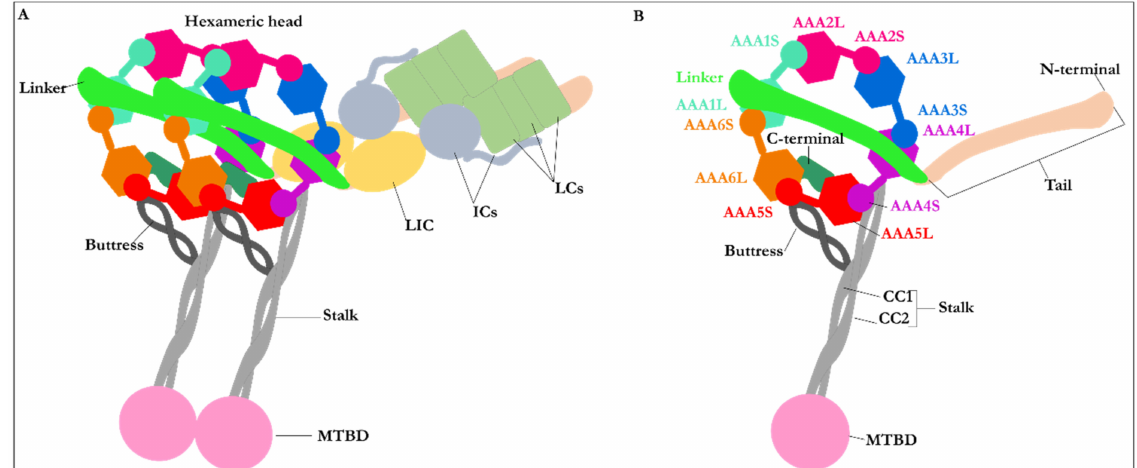
Figure 1. The multidomain structure of cytoplasmic dynein. ( A ) Schematic representation of the homodimer cytoplasmic dynein. For simplicity, only one monomer is labeled. The homodimer represents two heavy chains, two LICs, four ICs, and six LCs. Each set of the two heavy chains consists of a tail, a linker, a hexameric head, a buttress, a stalk, and an MTBD. The figures (e.g., the LCs, ICs, and LICs) are schematic. They do not represent their actual shape, ( B ) Schematic representation of the heavy chain of cytoplasmic dynein in its post-powerstroke conformation, with the linker straight and positioned on AAA4 near the stalk. The hexameric head represents the six AAA+ subunits with small (AAA + S) and large (AAA + L) subunits.